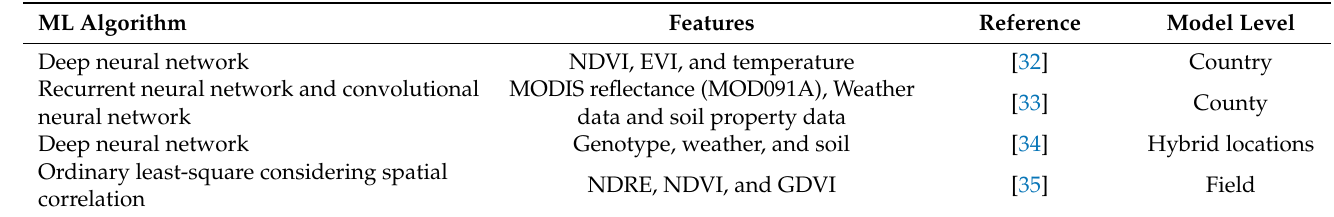
Table 1. Related works describing the algorithm, features, and model level used to predict corn